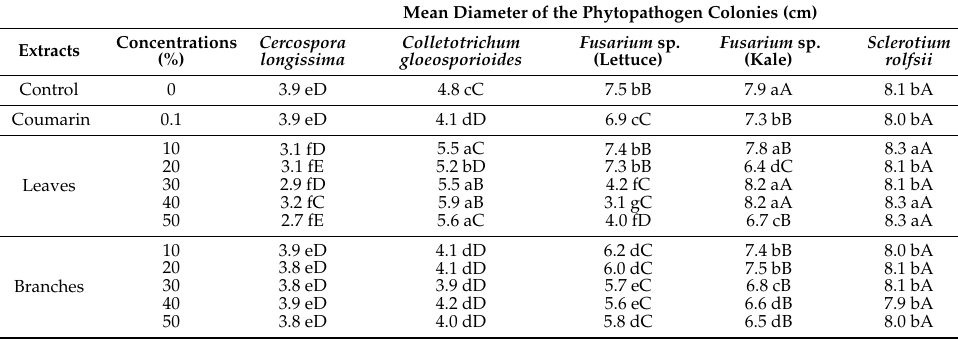
Table 5. Antifungal activity of the ethanolic extracts of D. punctata , in different